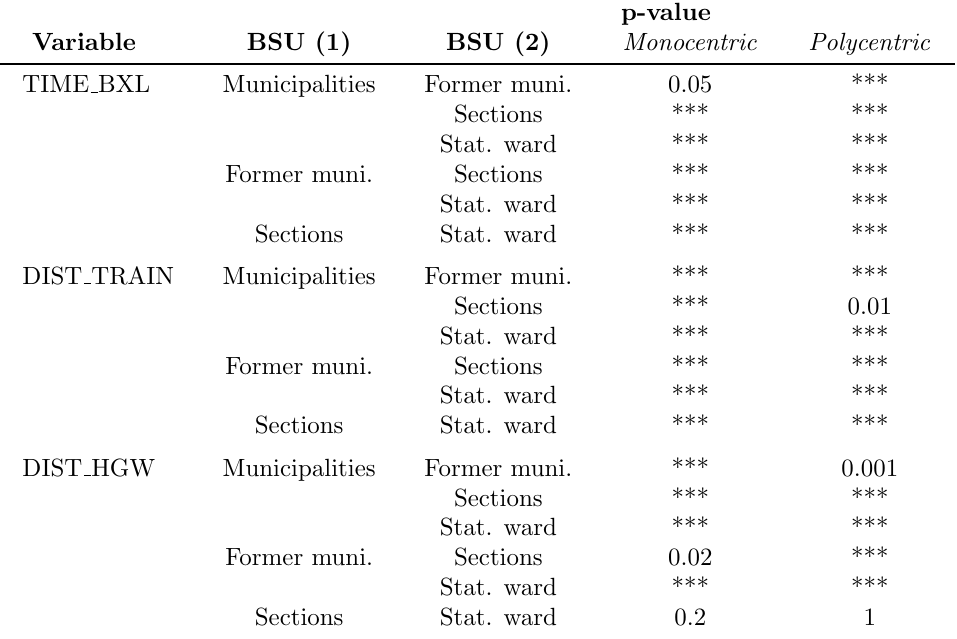
Table A.1: Pairwise t-test comparison of parameter estimates of the benchmark model through BSU (*** = significant at alpha = 0.001; Bonferroni adjustment of p-value)